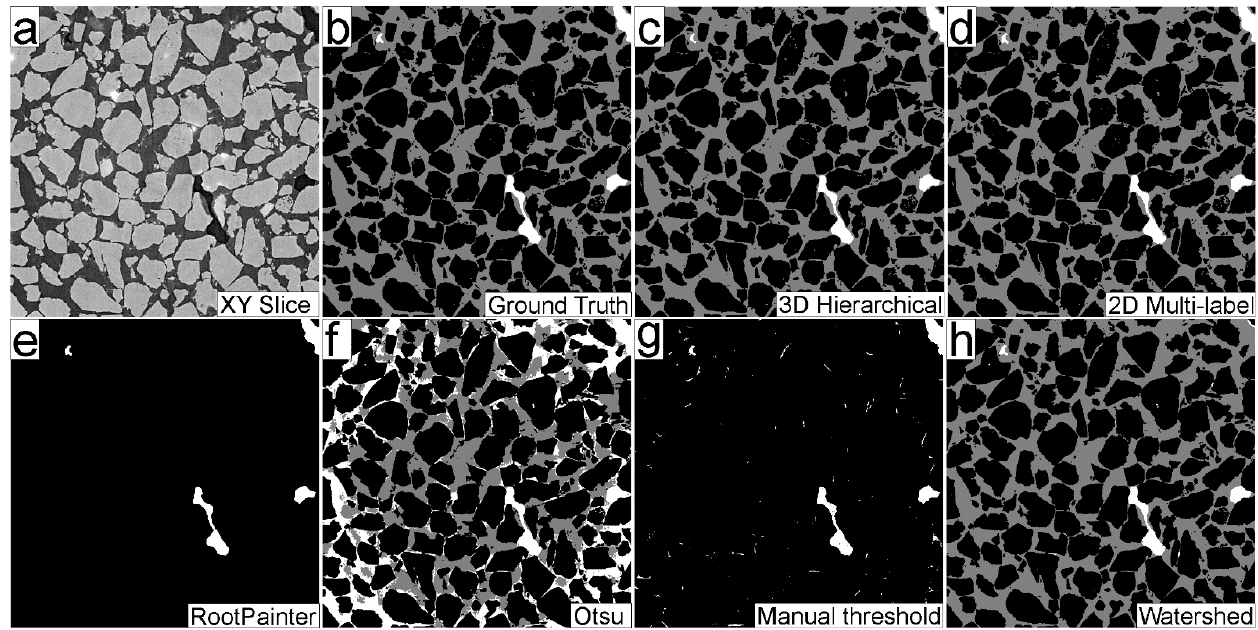
Figure 6. ( a ) Original XY central slice of dataset IC01; ( b ) hand-annotated ground truth labelled slice; ( c ) segmented slice using the 3D hierarchical method; ( d ) segmented slice using the 2D multilable singe-axis approach; ( e ) RootPainter segmentation of the CH 4 gas phase; ( f ) Otsu auto-threshold output; ( g ) manual thresholding output; ( h ) Watershed segmentation. CH 4 gas shown in white, brine in grey and sand in